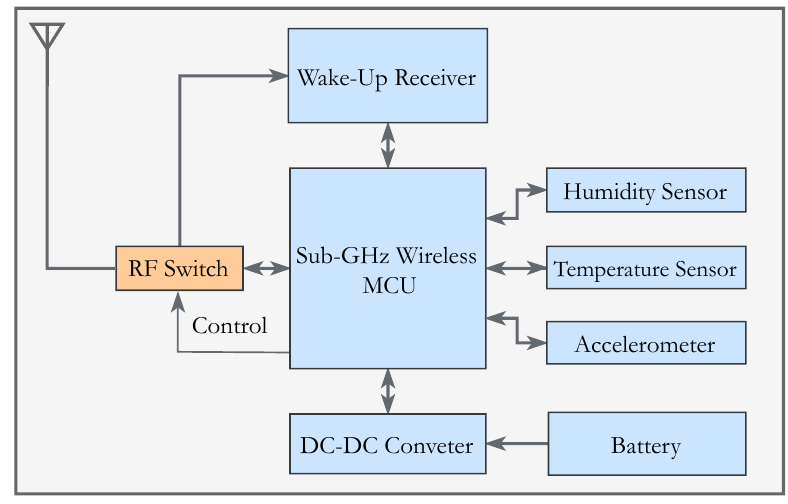
Figure 1. Block diagram of a typical sensor node embedded with a wake-up receiver